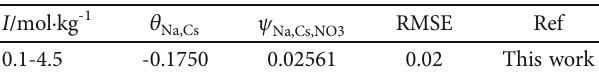
Table 6: Values of the mixing ion-interaction parameters of the Pitzer equation at 298.15K a .